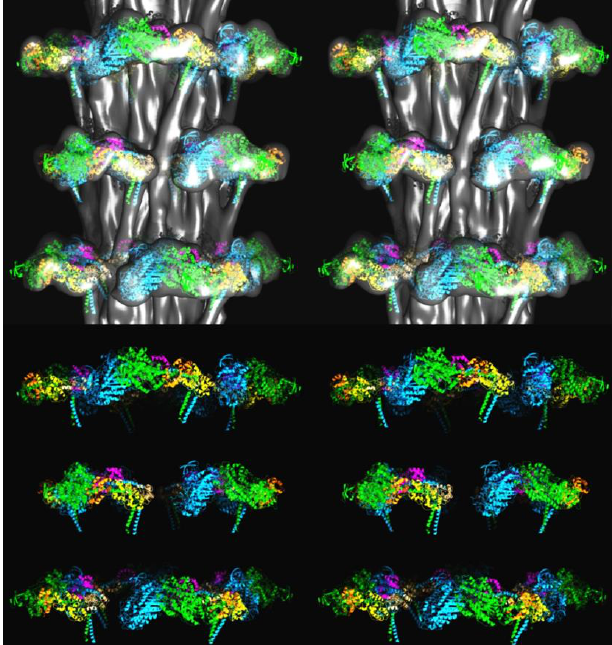
Figure 8. 3D structure of the insect flight muscle myosin filament according to Hu et al. [27] shown as stereo (wall-eyed) side views containing three crowns. ( Top ) Surface view of the density map, low pass Fourier filtered to 25-Å resolution, with fitted coordinates of atomic models of myosin heads in the interacting head motif arrangement, as determined in the present work, shown in cartoon representation. ( Bottom ) The atomic models without the density map. Coordinates colour-coded as follows: Free head heavy chain—cyan, essential light chain—magenta, regulatory light chain—straw: Blocked head heavy chain—green, essential light chain—orange, regulatory light—yellow.